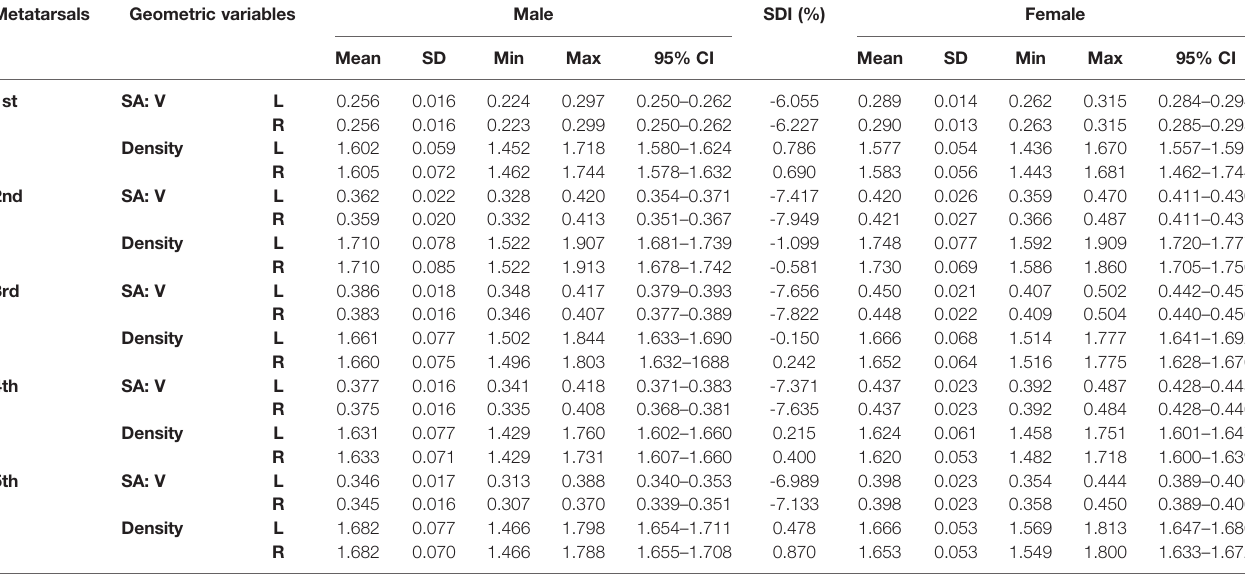
TABLE 2 | Descriptive results of SA: V (mm -1 ) and bone density (HU/1024) of metatarsal bone in vivo .